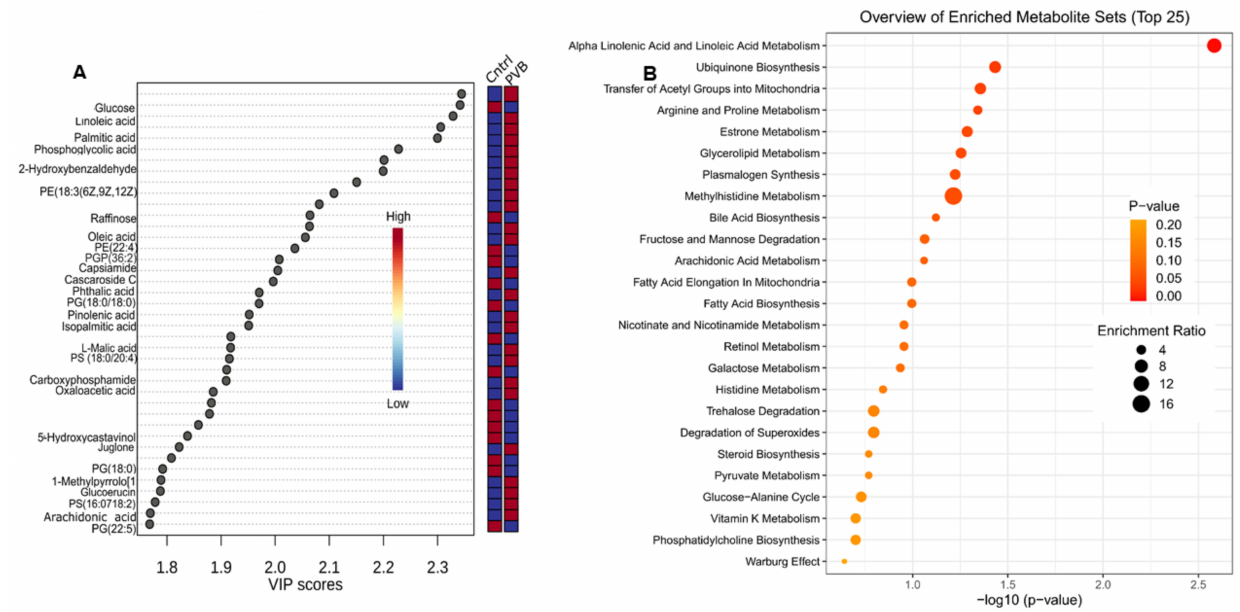
Figure 5. Metabolomic analysis in the upper lobe of PVB vs. Cntrl animals. ( A ) Metabolites ranked by Variable importance in the projection score (VIP) > 1 in PVB vs. Cntrl pigs in upper lobes based on OPLS-DA analysis. ( B ) Pathway analysis based on KEGG database of the enriched metabolites (VIP > 1 and p -value < 0.05 in the upper lobe of PVB vs. Cntrl swine. n = 6 in each group. The size of the dots represents the enrichment ratio and the shade of the color represent the − log 10 ( p